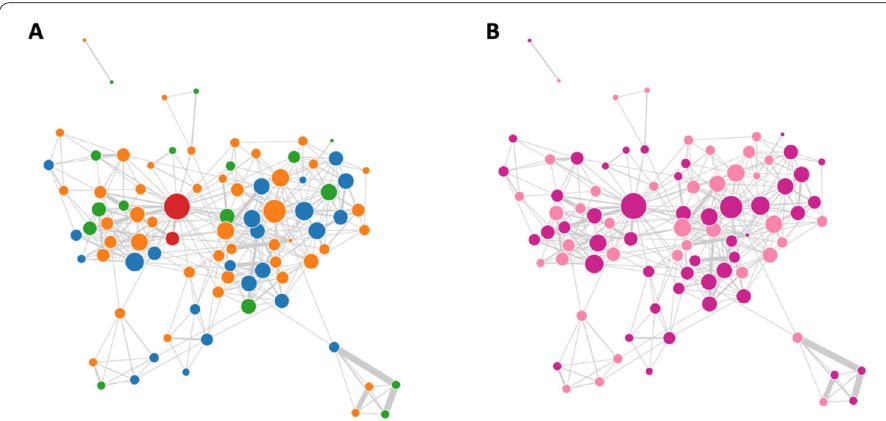
Figure 1 Contact network of the village. Nodes are color-coded according to the role: children: orange, adults: green, adolescents: blue, HSA: red (Panel A) and the gender: female: purple, male: pink (Panel B). Nodes’ size is proportional to their degree. Edge thickness is proportional to the total time spent in proximity by two connected